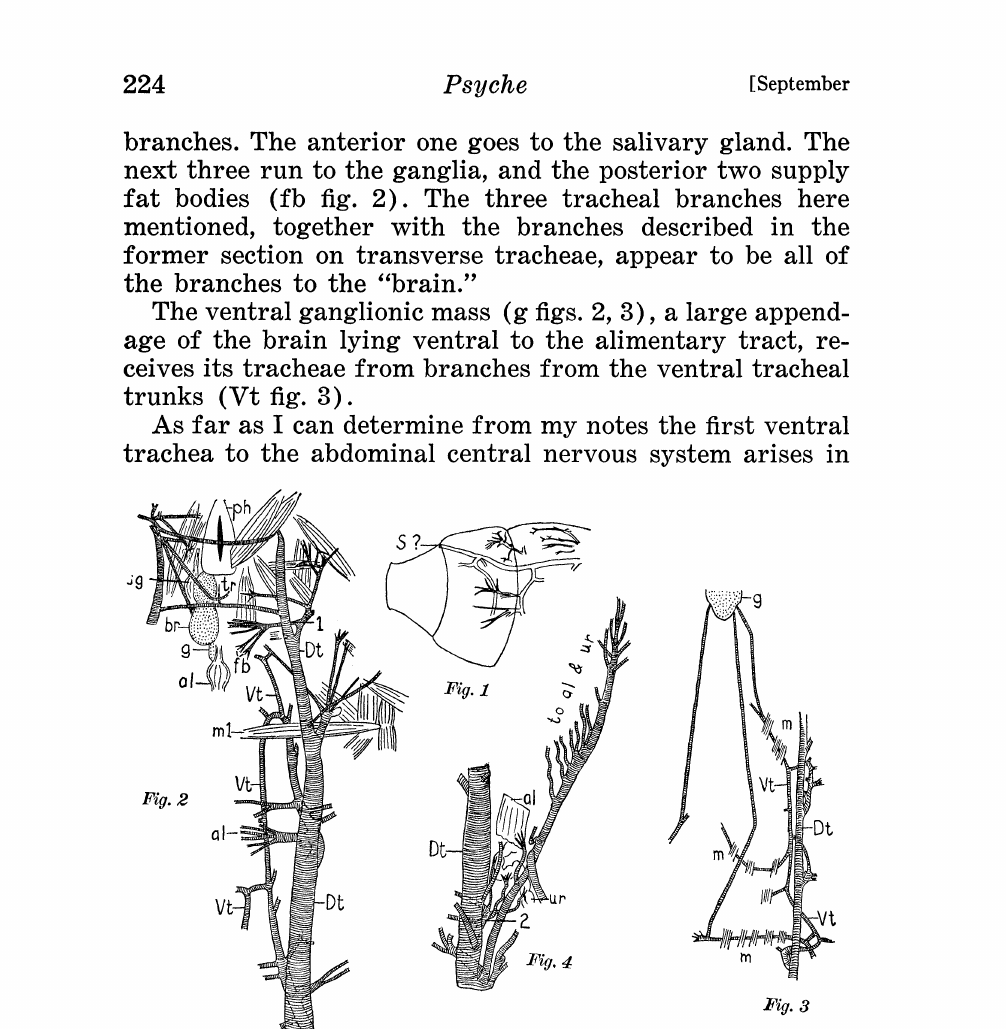
Fig. 1. Sketch of tracheae as seen through the body wall in the anterior end of a larva. Fig. 2. Tracheae and organs in anterior part of body. Fig. 3. Tracheae to the ventral ganglionic mass. Fig. 4. Study of tracheae in posterior end of body. al, alimentary tract, and trachem to alimentary tract; br, "brain"; Dt, dorsal tracheal trunk; fb, tracheae to fat bodies; g, ventral ganglionic mass; m, muscle layer; ml, muscle crossing ventral tracheal tract; ph, pharynx; S?, position of anterior spiracle?; sg, salivary gland; tr, transverse trachea; ur, urinary tubule; Vt, ventral longitudinal trunk; 1; trachea branching to gland, ganglia and fat bodies; 2, trachea sending branches to urinary